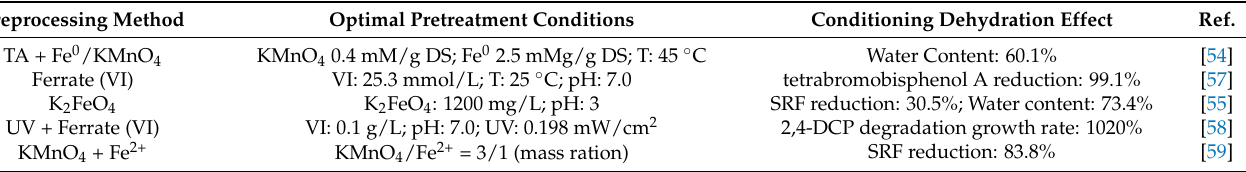
Table 4. Study results of enhanced sludge dewatering by permanganate and ferrate pretreatment. Preprocessing Method Optimal Pretreatment Conditions Conditioning Dehydration